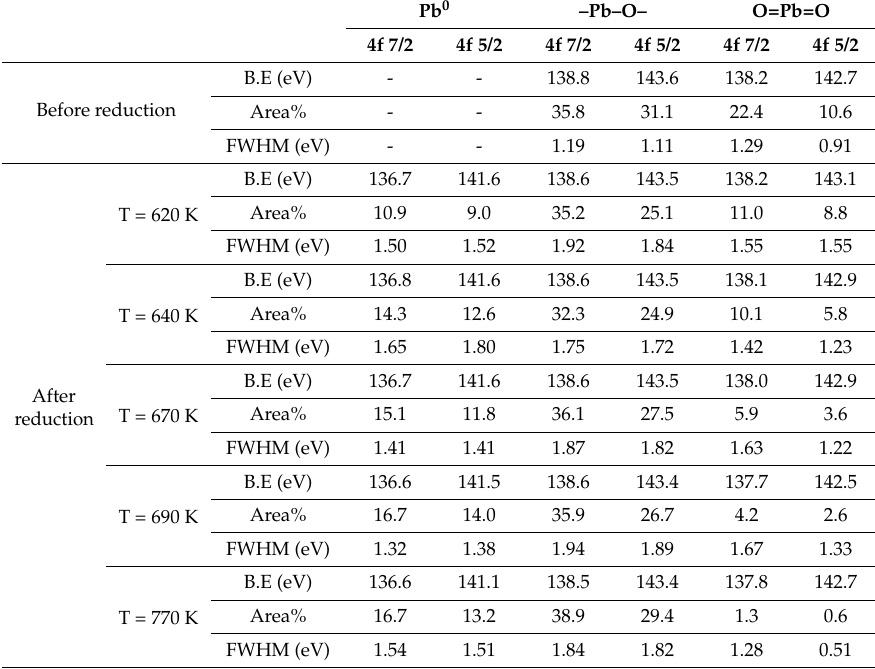
Figure 5. The concentration of Pb 4f 7/2 in the conducting layer of the channel wall before and after hydrogen reduction. On the left of the break in abscissa was before reduction, on the left of which was after reduction at different reduction temperatures. The purple squares, blue dots and gray circles means the area ratio of 4f 7/2 binding energy peak of Pb 0 , PbO and PbO 2 , respectively. Table 3. The fitting data of the XPS spectra Pb 4f for the microchannel wall of CML865 MCP.